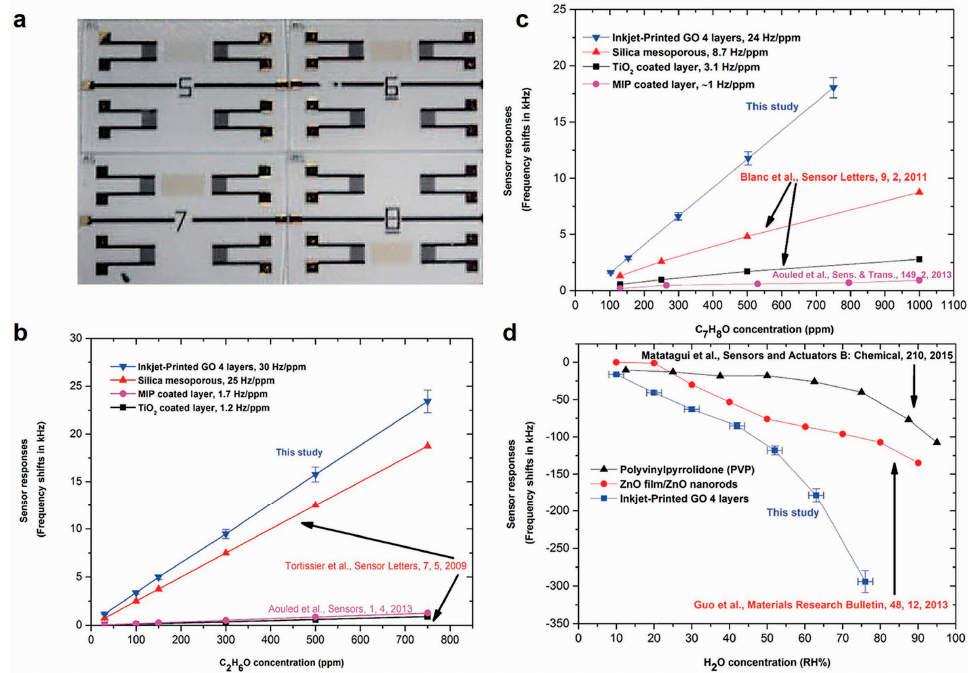
Figure 2. ( a ) Inkjet-printed graphene oxide on LOVE wave device. ( b – d ) Ethanol (C 2 H 6 O), toluene (C 7 H 8 ) and H 2 O responses respectively, of di ff erent sensing layers (GO, ZnO film / ZnO nanorods and PVP) [85]. Reproduced with permission from IEEE.